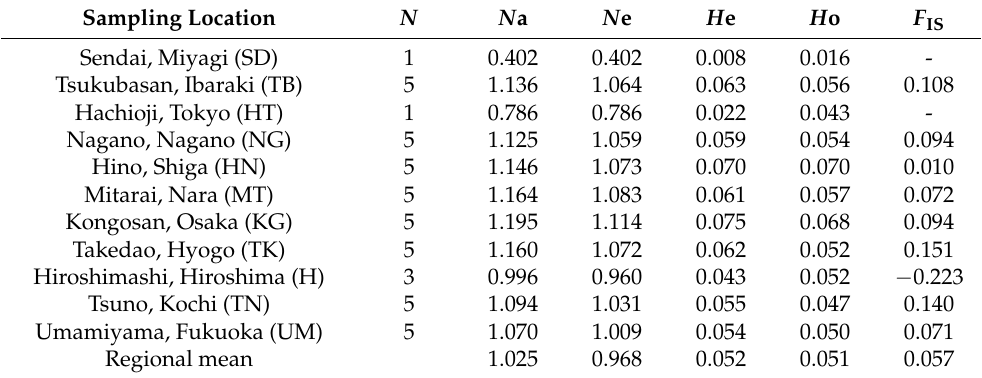
Table 2. Genetic diversity parameters of the 11 populations of Lindera praecox (Lauraceae) in Japan based on 355 SNP loci. Letters in parentheses are abbreviations of sampling location.